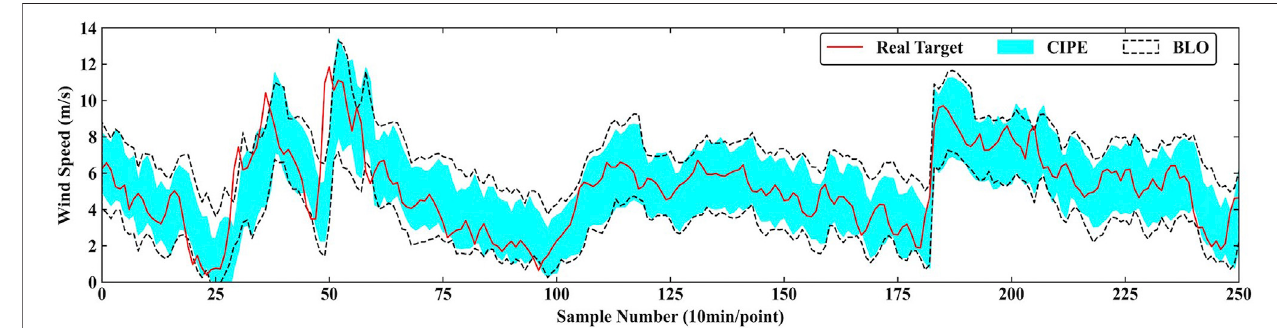
FIGURE 7 | Prediction result of CIPE and BLO under PINC = 90% in 2-step ahead prediction.